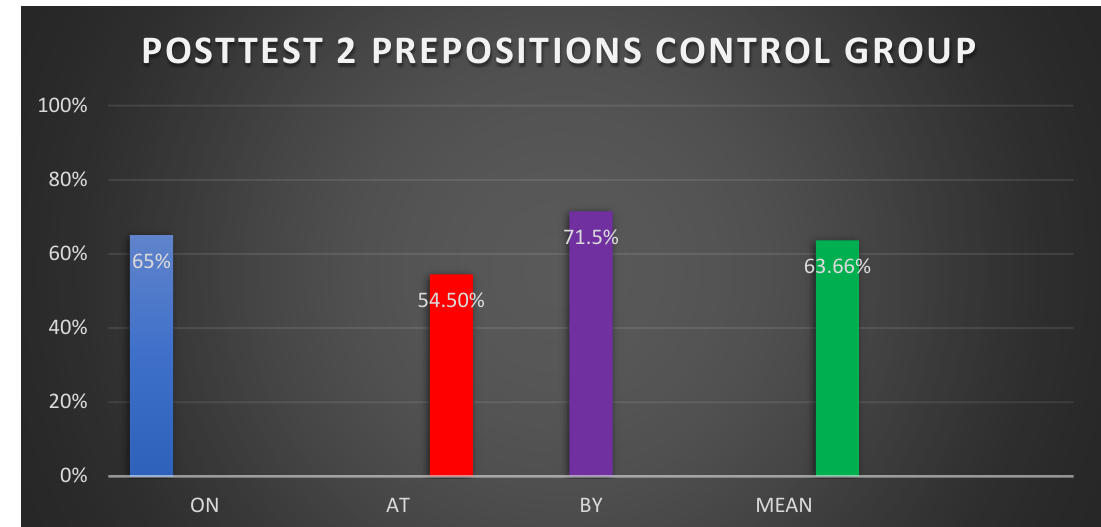
Figure 7. Posttest 2 control group prepositions and means.